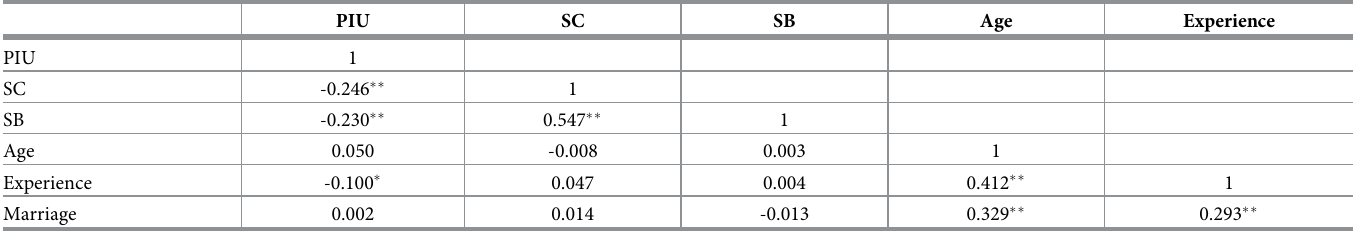
Table 3. Correlations among variables investigated in this study.